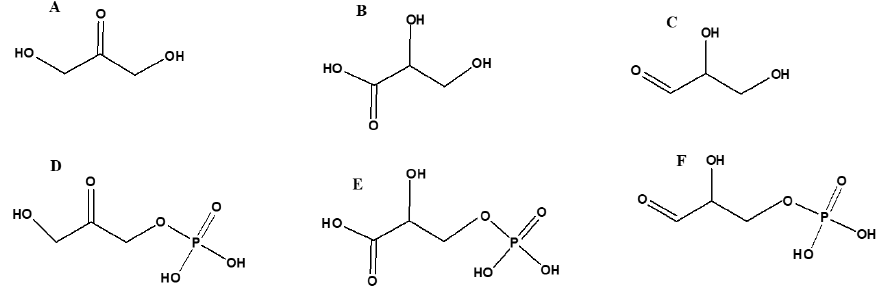
Figure 13. The various oxidation products of glycerol and their phosphorylated derivatives: (A) DHA, (B) glyceric acid, (C) glyceraldehyde, (D) DHAP, (E) phosphoglyceric acid, and (F) glyceraldehyde phosphate.